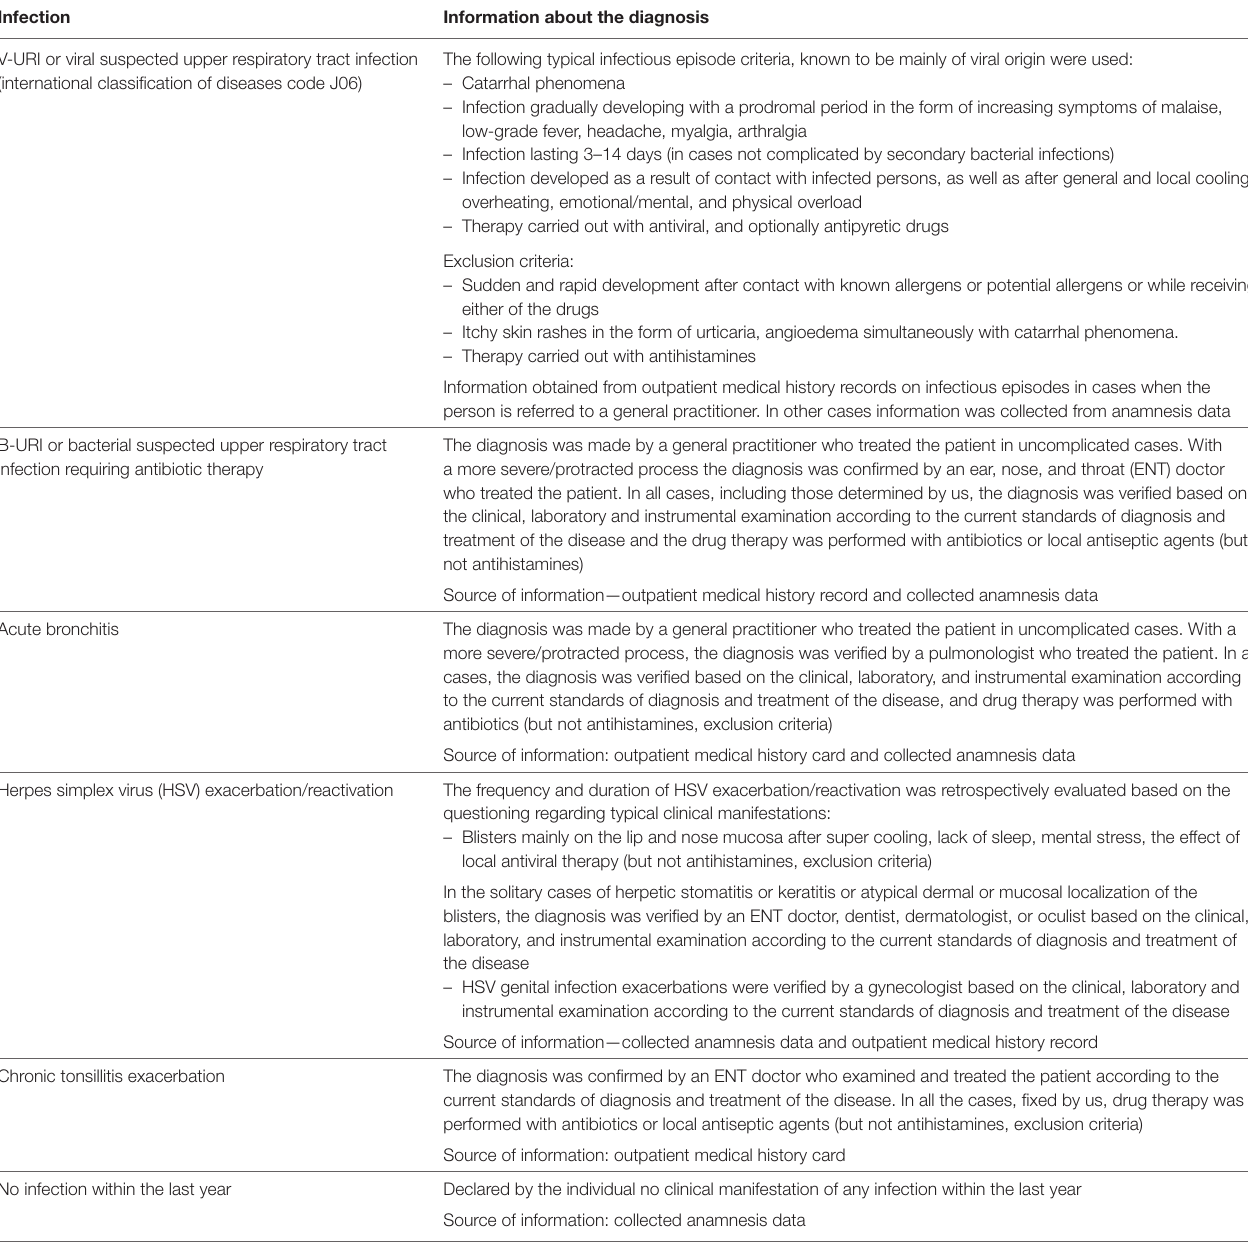
Table 1 | Criteria used in the study to establish infectious episodes within the last year. infection information about the